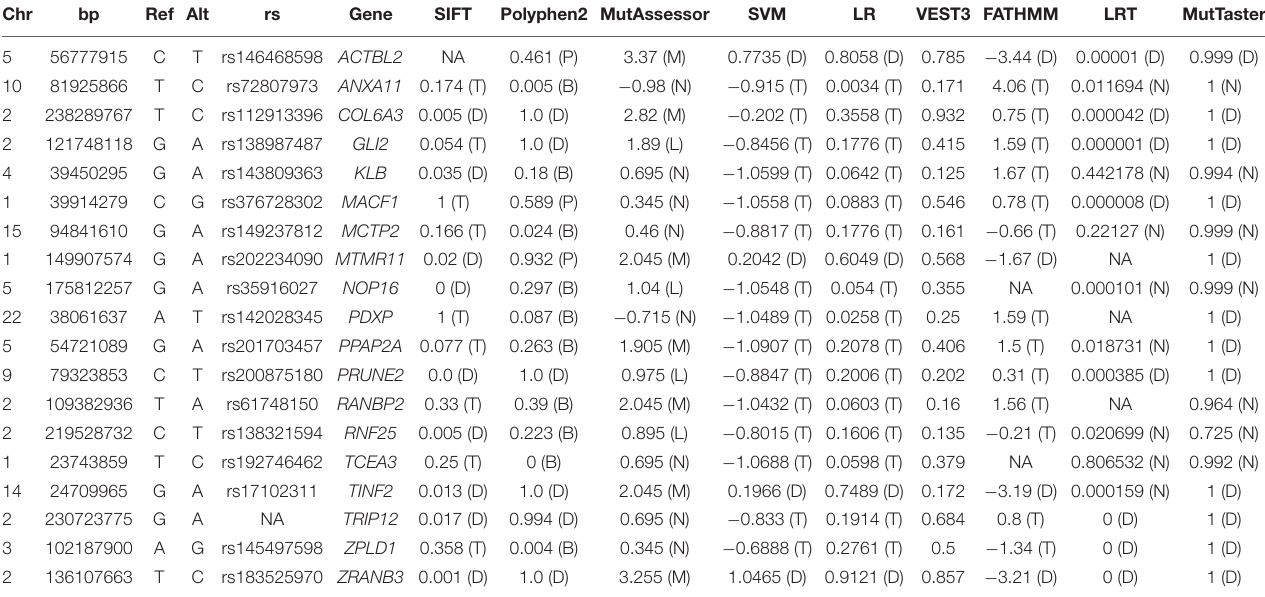
TABLE 3 | Protein prediction